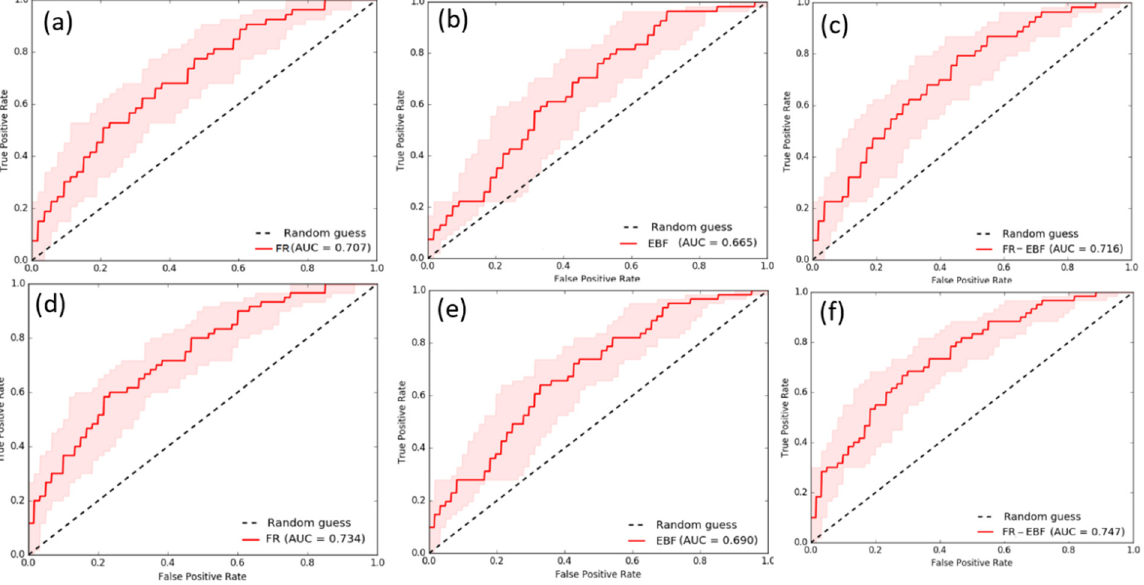
Figure 9. AUCs of predicted GWPZ models: ( a ) FR, ( b ) EBF, and ( c ) FR–EBF testing models; ( d – f ) using training samples.